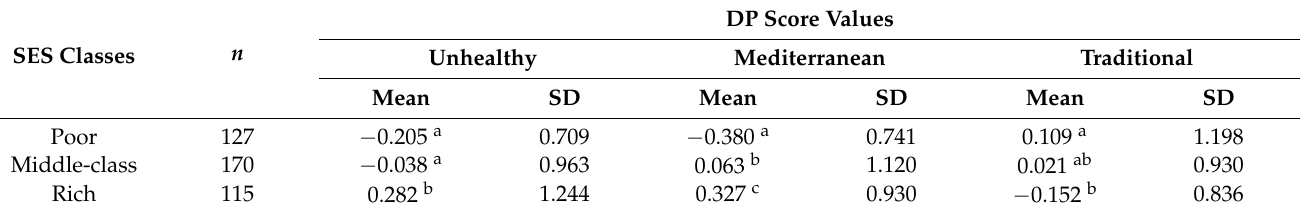
Table 4. Means and standard deviations of DPs among different SES